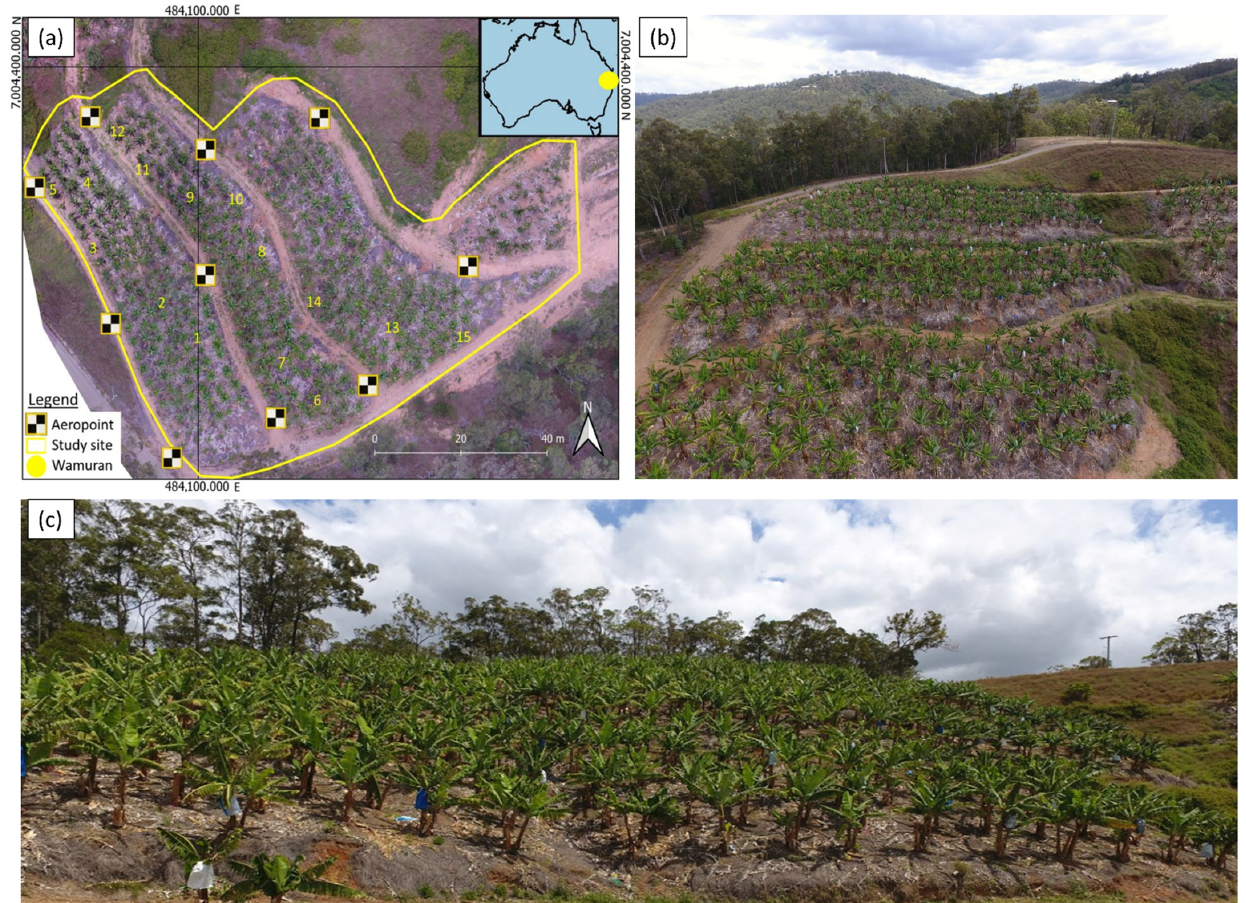
Figure 2. ( a ) Location of study site in Wamuran, Queensland, Australia, illustrating typical Aeropoint distribution used for georeferencing of the UAV data and with plant locations of field measurements numbered; ( b ) aerial view; and ( c ) photograph of the upper portion of the study site taken from the northeastern corner of the site, facing southwest.